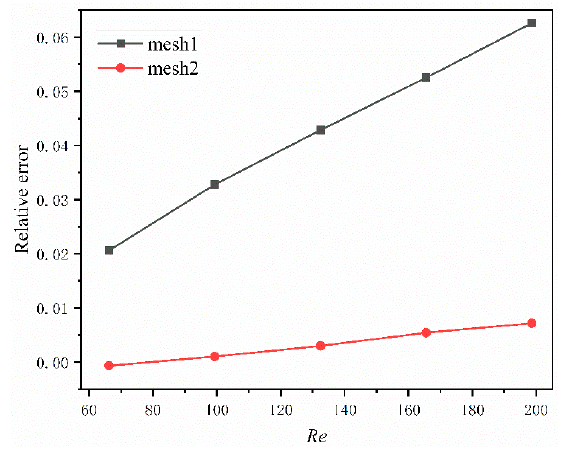
Micromachines 2019 , 10 , x Figure 2. Grid-independent test for DL-T micromachine structure. Figure 2. Grid-independent test for DL-T micromachine structure.